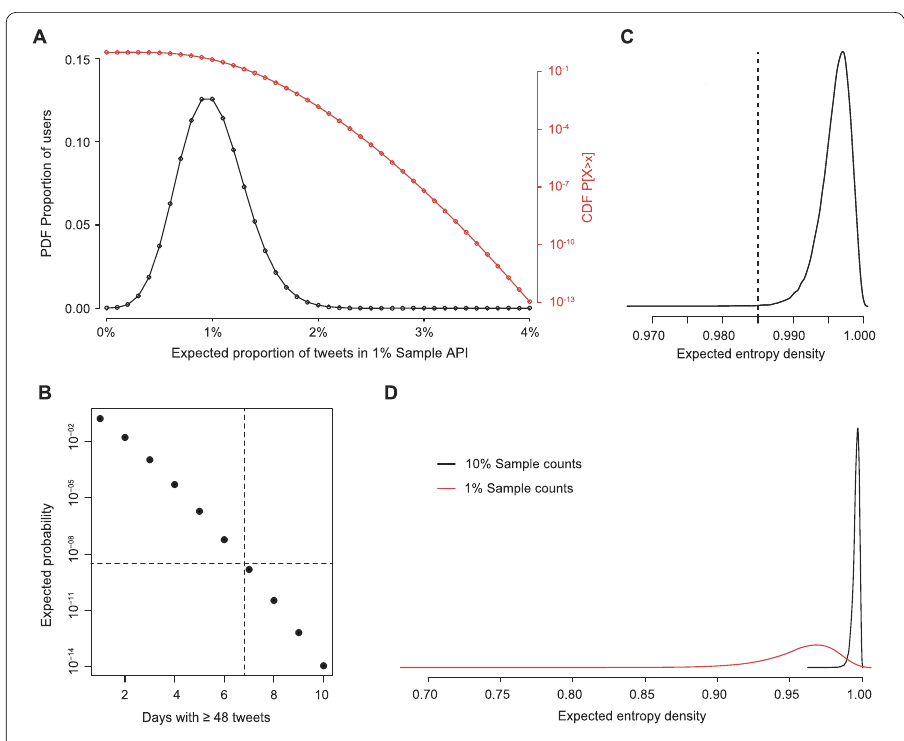
Figure 4 Estimating suspicious values. ( A ) Binomial distribution ( n = 1000, p = 0.01) to estimate the expected exact proportion of Tweets per user in the 1% Sample API with n % Tweets in 1% Sample API (PDF, black line) as well as accumulated probabilities (CDF, red line), e.g. 3 out of 1000 users reach at least 2% coverage. ( B ) Expected probability that an account has ≥ 2% coverage on x days. The suspicious threshold p (dashed lines) is set to 1/ N , where N = 328 M , the overall number of active Twitter accounts. ( C ) Expected entropy scores for millisecond distribution of accounts in 10% Sample. Values below 0.985 can be considered as very rare events, i.e. suspicious. ( D ) Expected entropy density for the 1% Sample and 10% Sample to illustrate that identifying suspicious entropy scores (i.e. outliers) is easier in the 10%